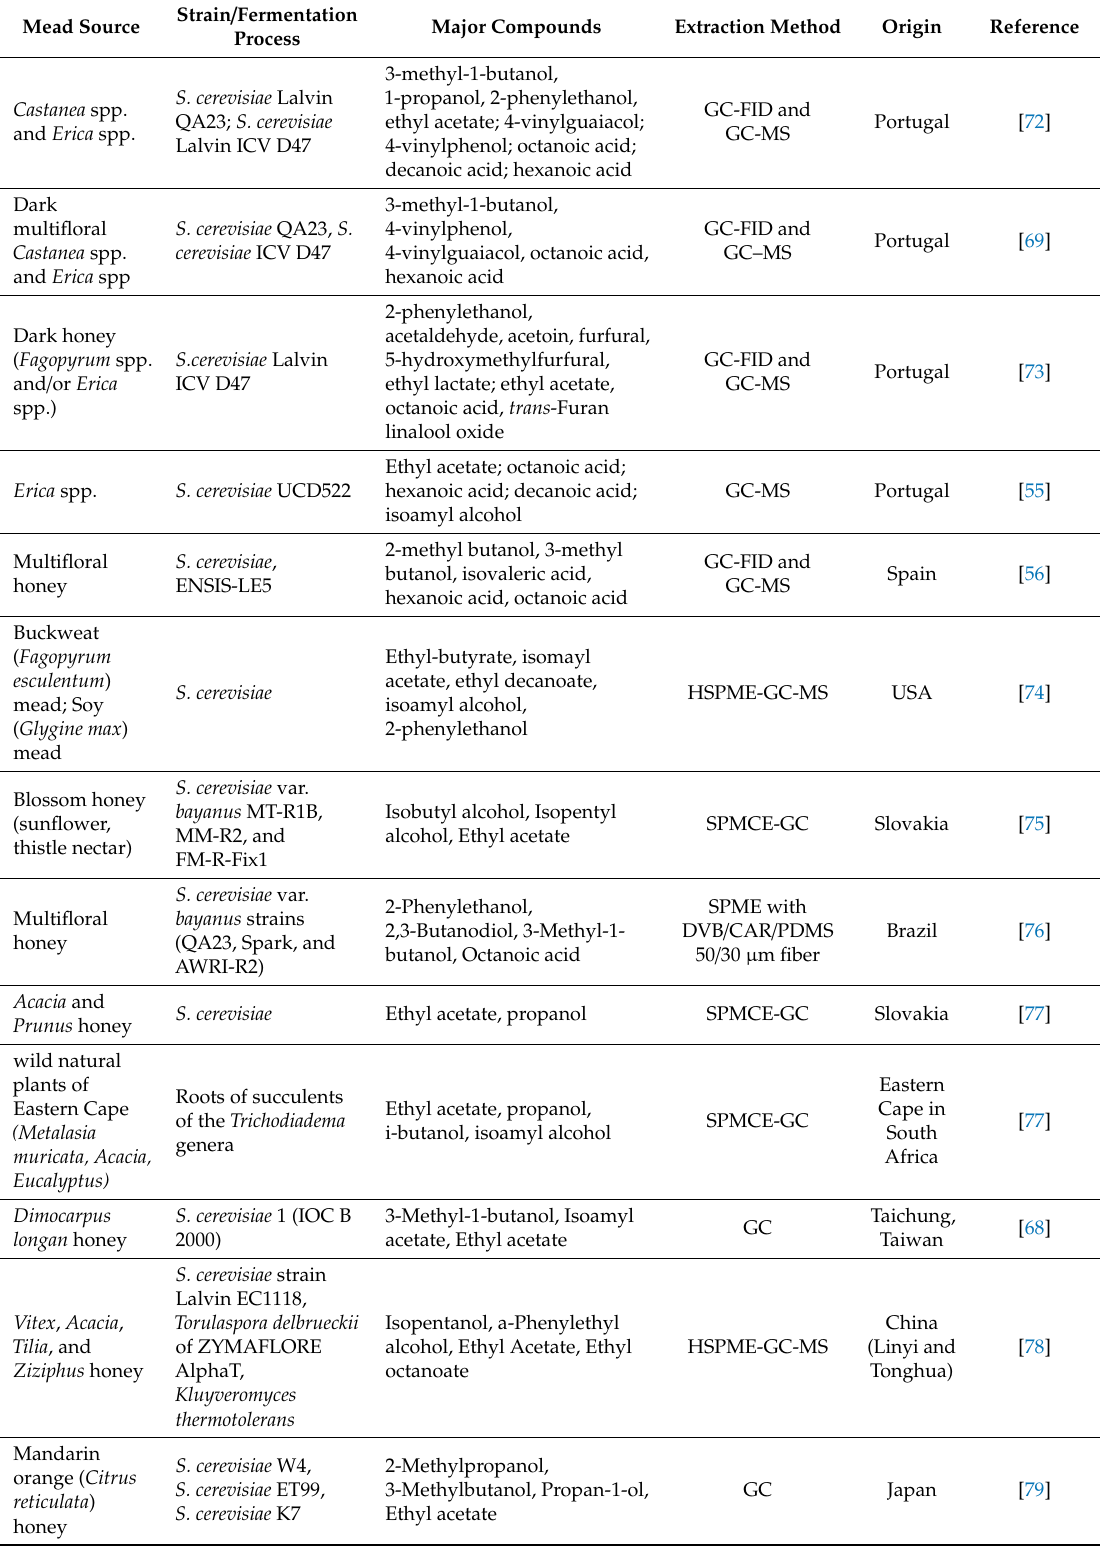
Table 2. Floral markers used to determine the botanical origin of mono and multifloral honey. Mead